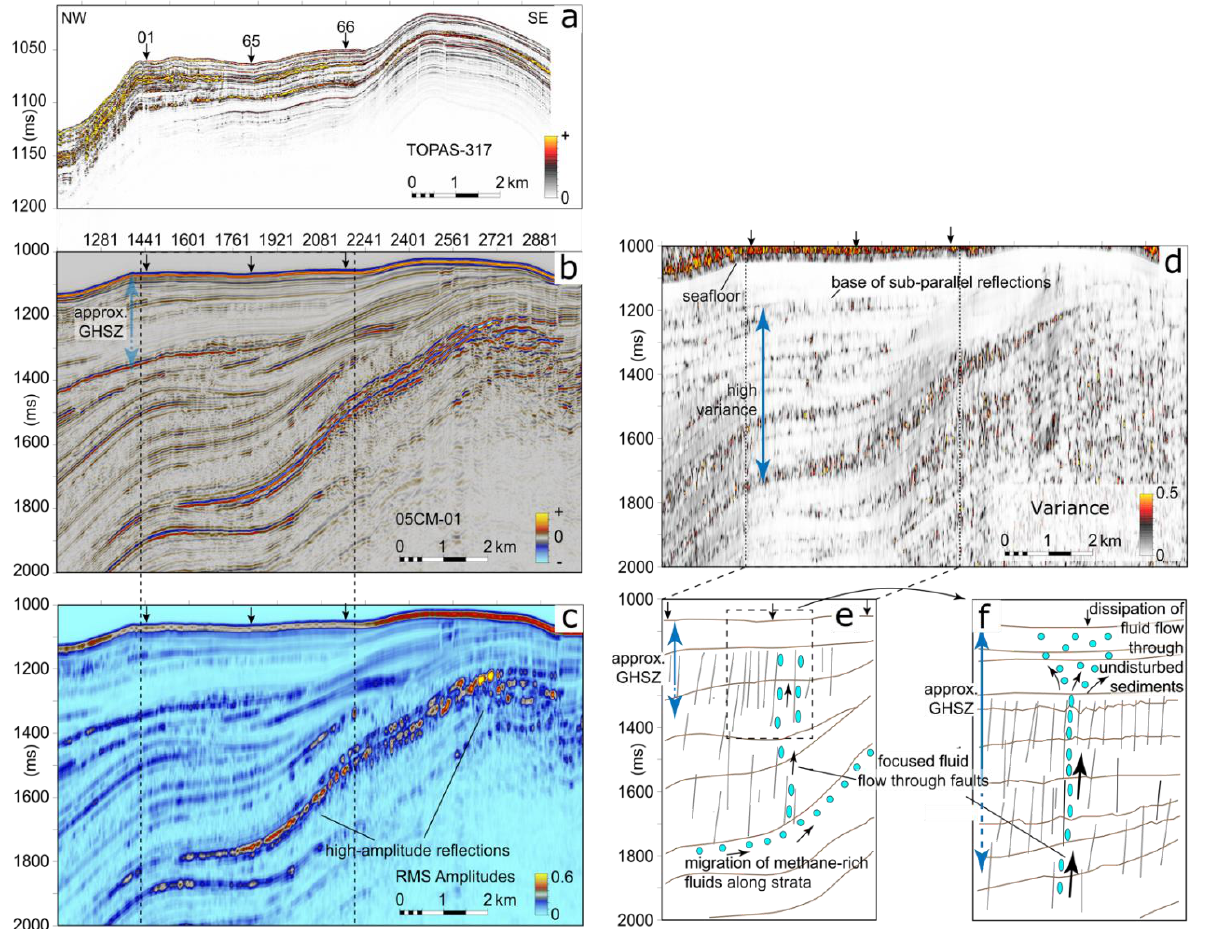
Figure 2. Geophysical data and interpretations at the Control Site (see Figure 1b for location). ( a ) TOPAS data showing the locations (black arrows) of Piston Cores 01, 65 and 66 (see Figure 1b for geographic locations). ( b ) Multichannel seismic data — amplitudes. Same horizontal scale, but different vertical scale than ( a ). GHSZ: Gas hydrate stability zone (see text for details). ( c ) root-mean- square (RMS) amplitudes from ( b ). Identical scale and extent as ( b ). ( d ) Variance attribute of the seismic data in ( b ). Identical scale and extent as ( b ). ( e ) Structural interpretation of the seismic data that may explain the lack of BSRs in the presence of high CH 4 flux near the surface (see discussion). Note: interpretation extent is from the vertical dotted lines in ( d ), which are also shown in ( b ) and ( c ). ( f ) Enlargement of shallow part of our interpretation, from the broken black box in ( e ).